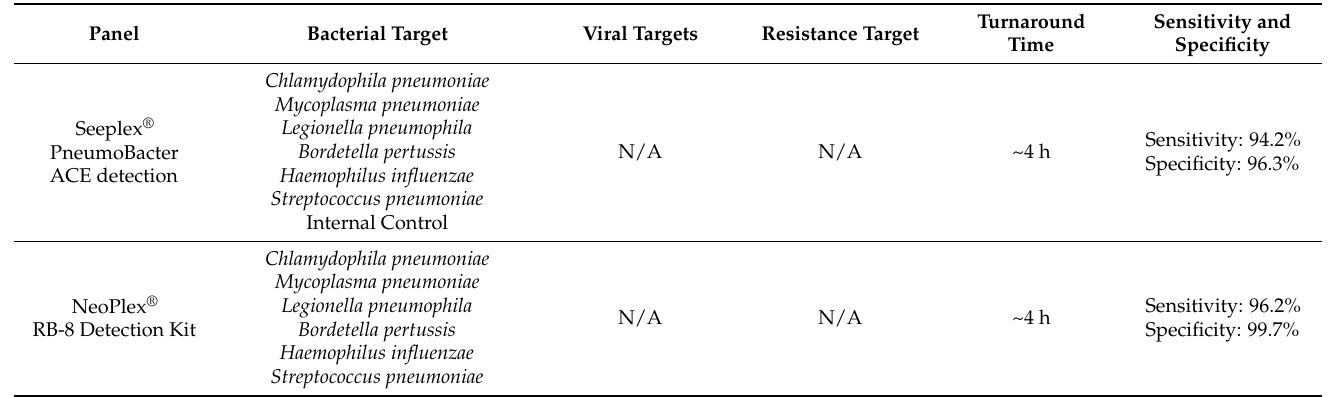
Table 4. Comparison of Various Rapid Respiratory Panels Continued